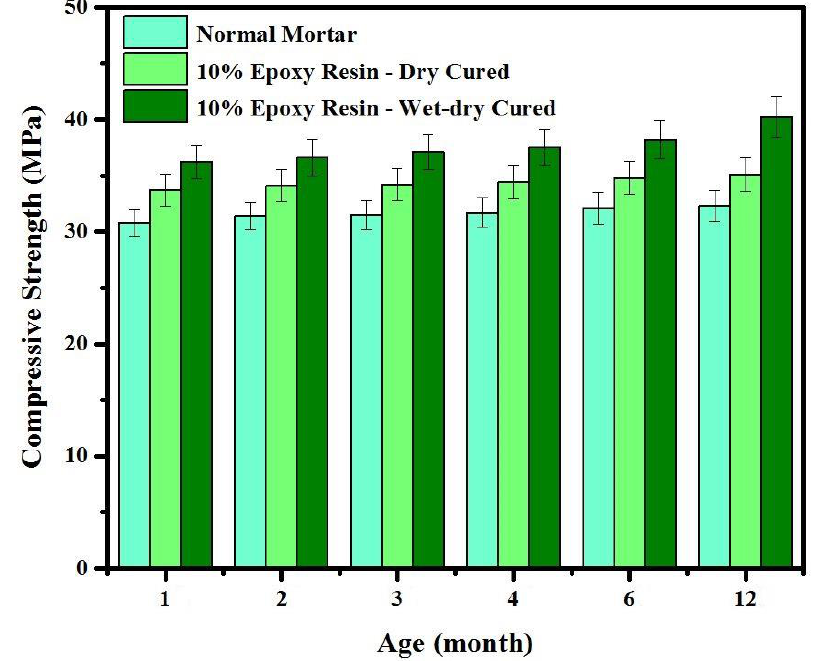
Figure 7. Effects of curing age on compressive strength development.